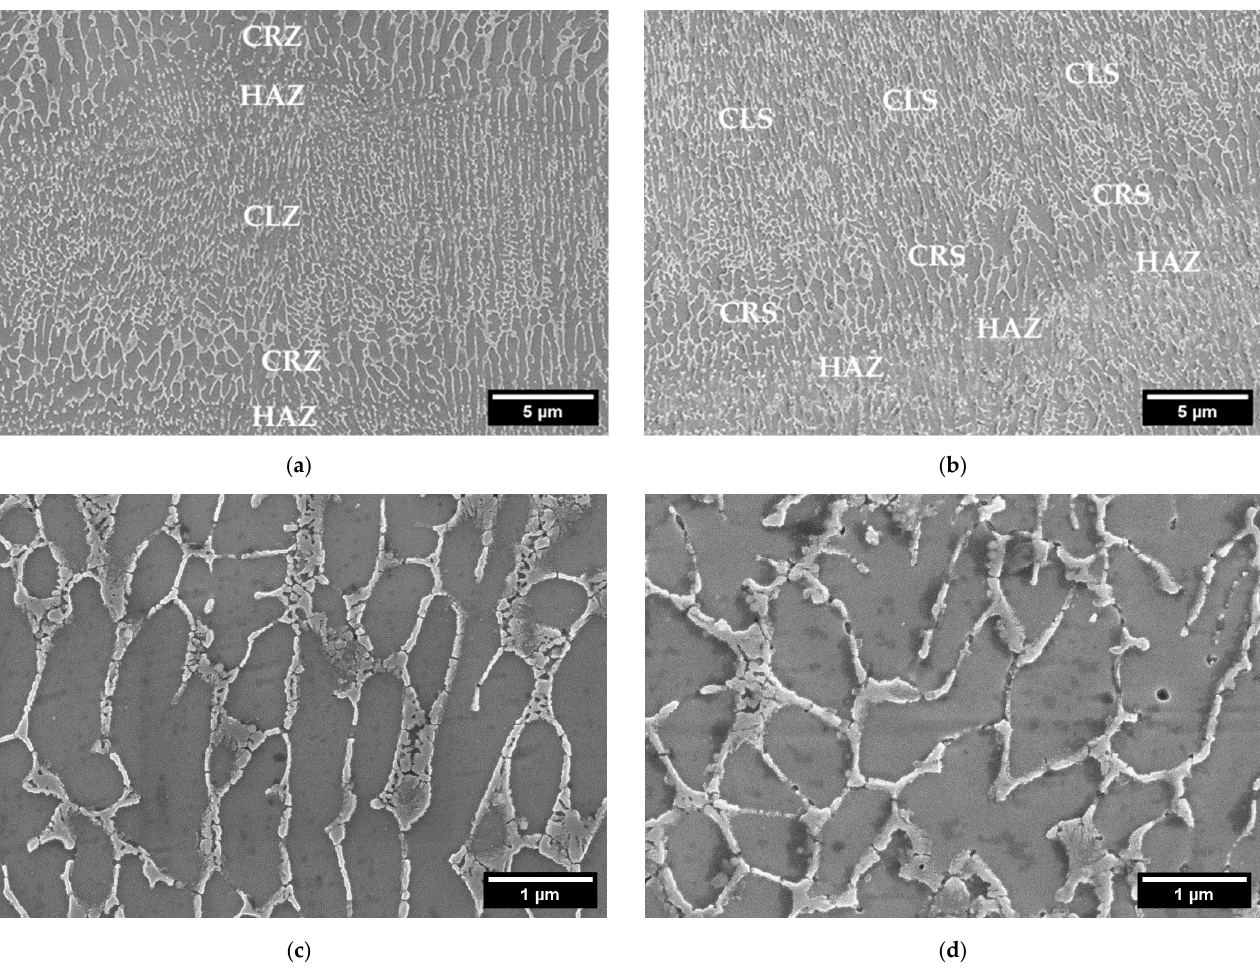
Figure 5. FESEM microstructures at a high magnification of CL31 ( a ) and HM ( b ) at 10 kX and CL31 ( c ) and HM ( d ) at 50 kX. CL31 ( c ) and HM ( d ) at 50